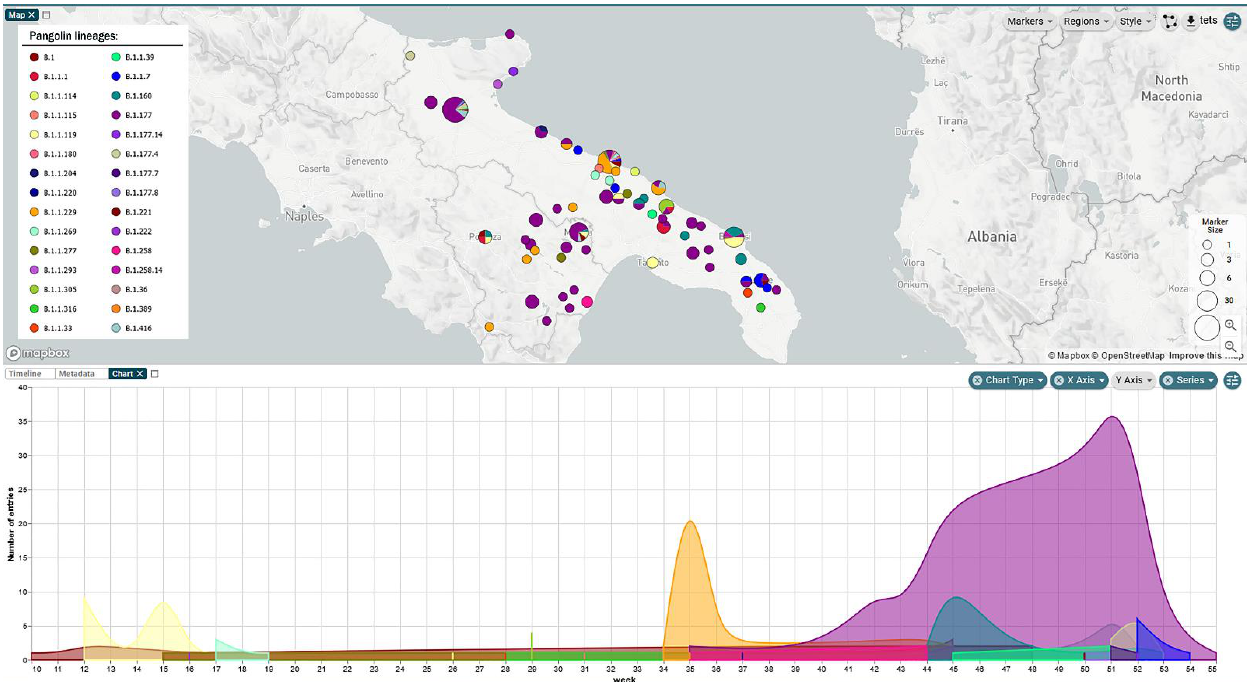
Figure 1. Pangolin lineages detected in Apulia and Basilicata regions, from March 2020 to January 2021.